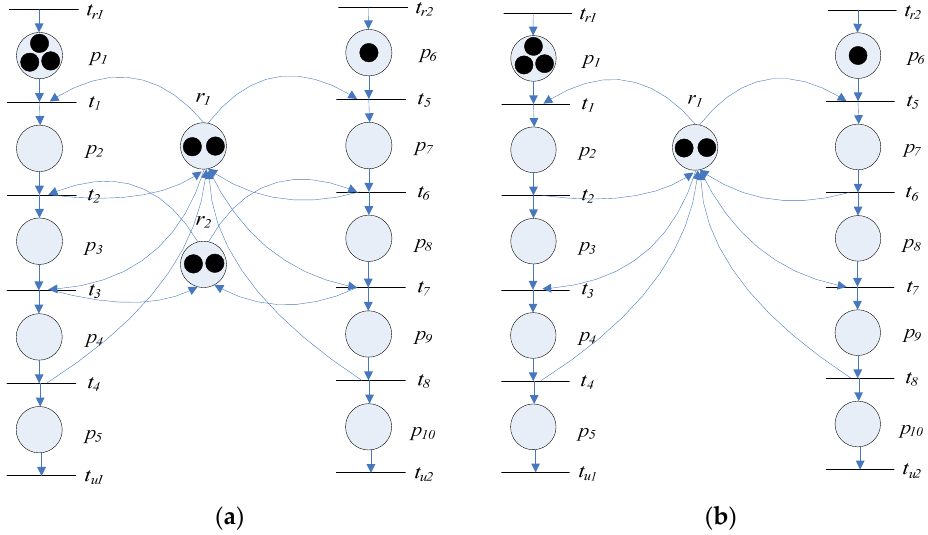
Figure 3. ( a ) Overall model obtained by merging Figure 1 with Figure 2; ( b ) A model which allows at most one resource involved for each transition.